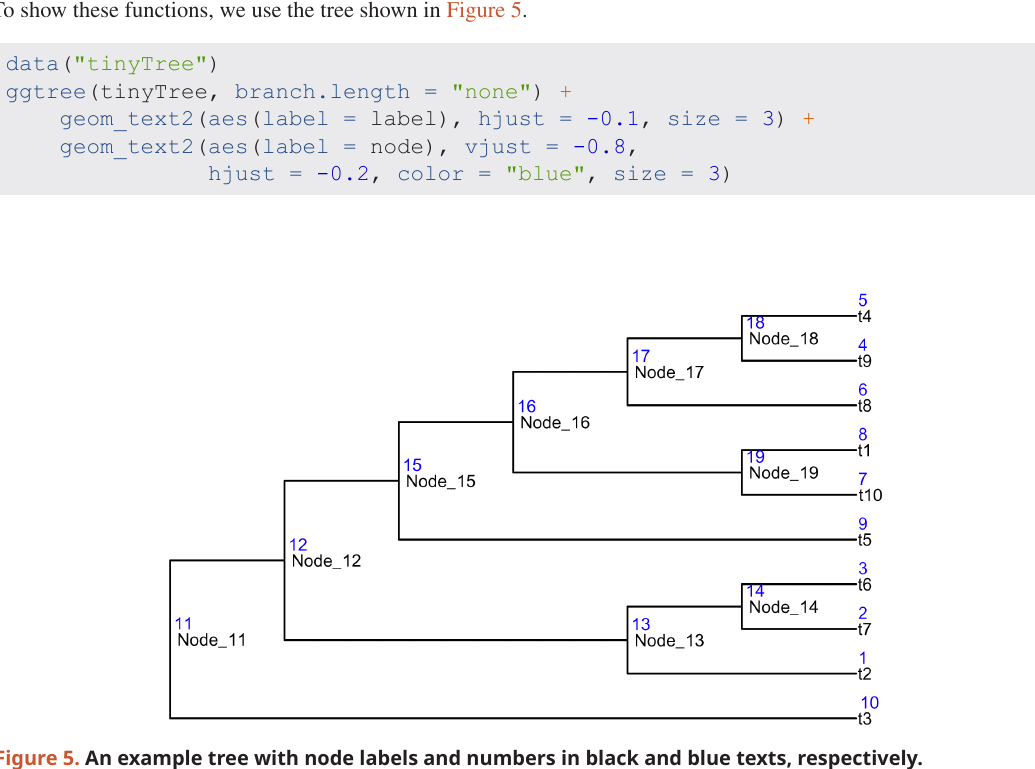
Figure 5. An example tree with node labels and numbers in black and blue texts,